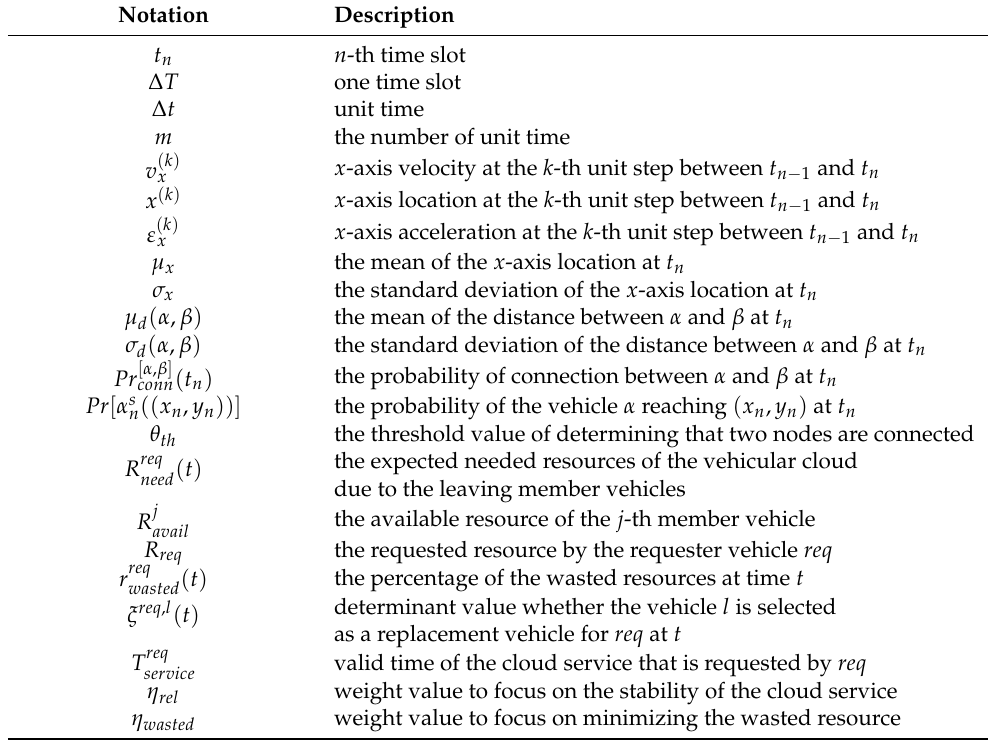
Table 1. Notations used in the proposed